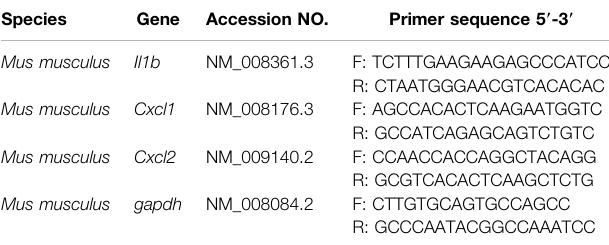
TABLE 2 | Primer sequences used for real-time qPCR.